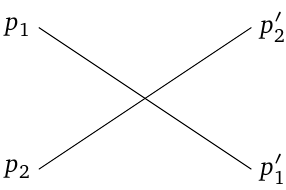
Figure 7: Visual depiction of a 2-body scattering event. The unprimed quantities describe the values before the scattering, the primed ones after the